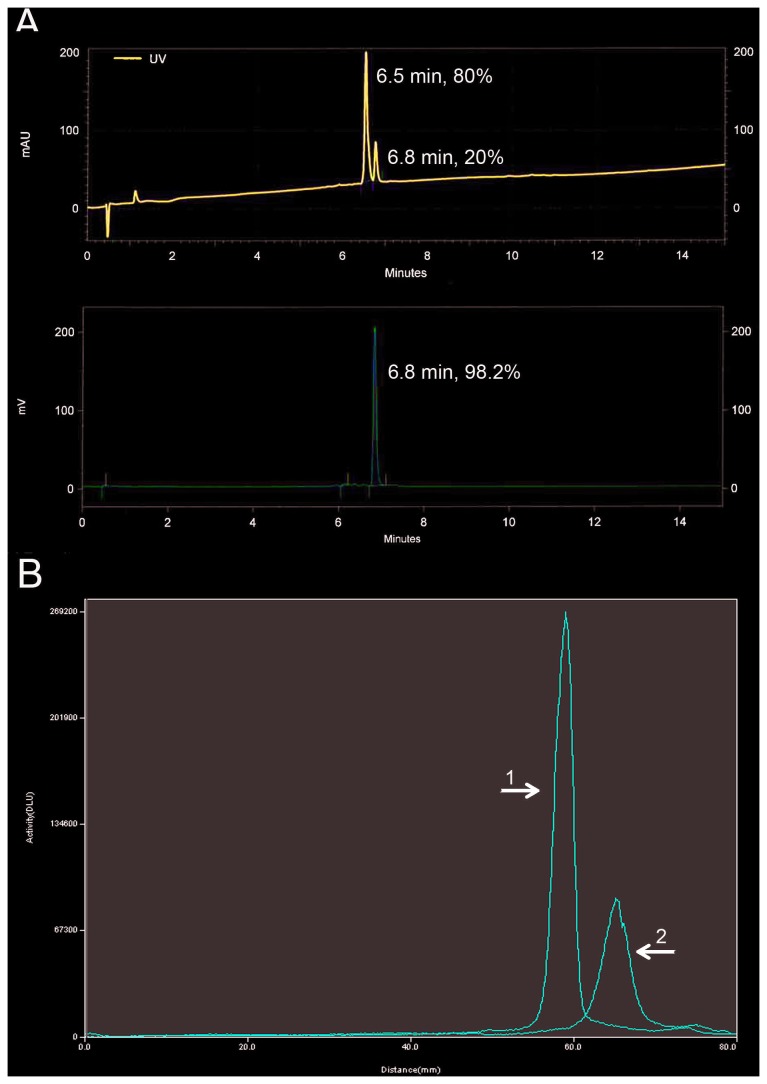
UV-radio-HPLC and SDS-PAGE analysis.
A. UV-radio-HPLC analyses of [18F]AlF-NOTA-P2-RM26. Upper panel: UV profile with signals corresponding to the original conjugate, NOTA-P2-RM26 (6.5 min), and the product, [18F]AlF-NOTA-P2-RM26 (6.8 min). The recording wavelength was 220 nm. The analyte was spiked with the original conjugate in order to confirm the identity. Lower panel: Radioactivity profile with the principle signal (>98%) corresponding to the product, [18F]AlF-NOTA-P2-RM26. B. SDS-PAGE analysis of [18F]AlF-NOTA-P2-RM26 after a 1 h incubation in murine serum at 37°C (1). Radiolabeled sample (2). Na18F-sodium fluoride was used as low molecular weight radioactivity marker on the same gel.